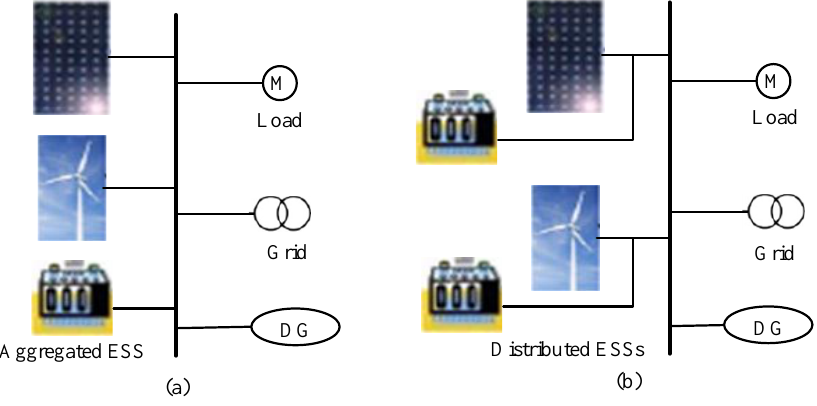
Figure 1. Illustration of energy storage system (ESS) configurations. ( a ) Aggregated ESS; ( b ) Distributed ESS.